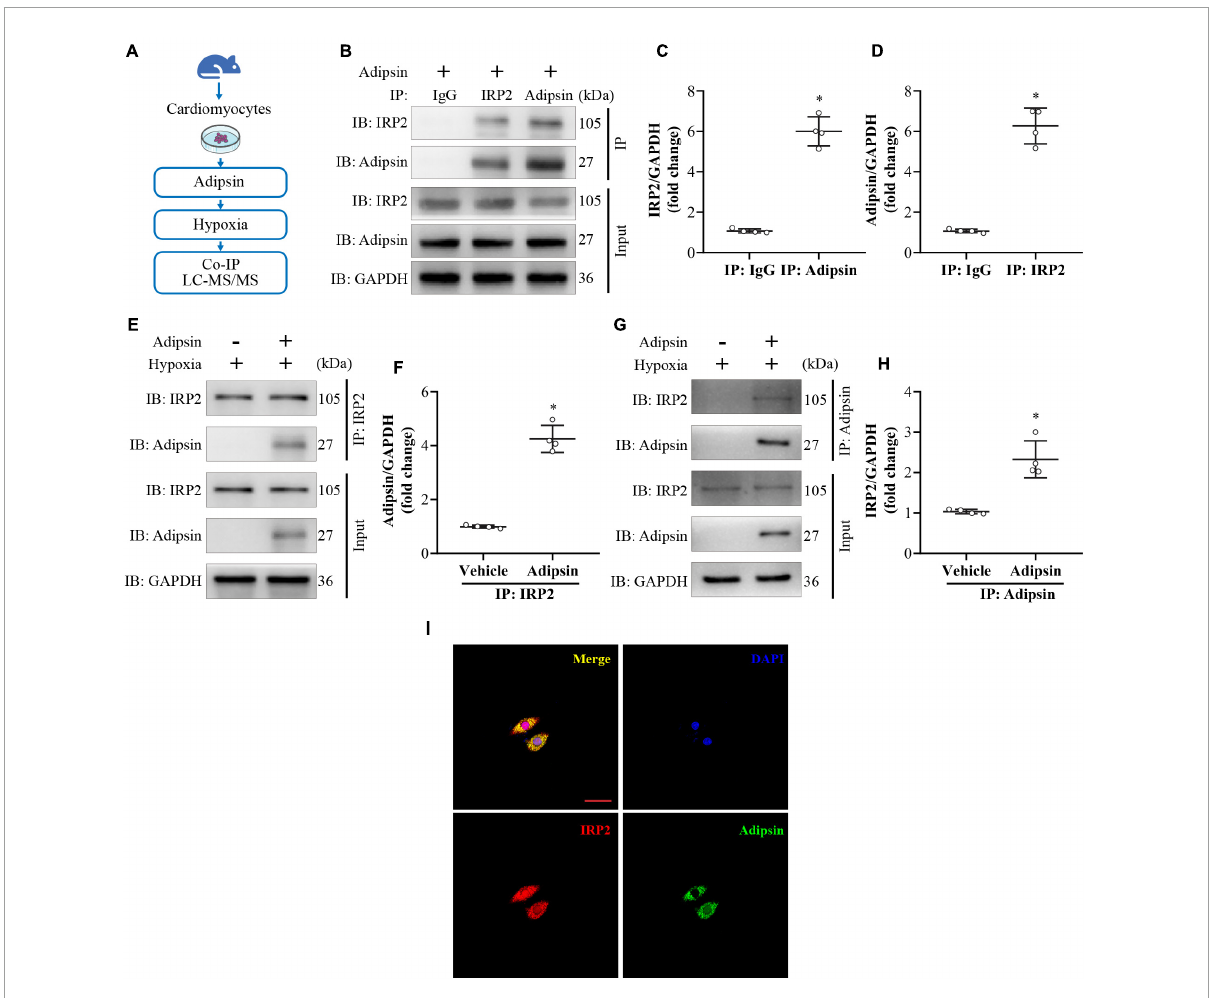
FIGURE6 Adipsin interacts with IRP2 under hypoxia in vitro . (A) Flowchart of the study design. Neonatal mouse ventricular cardiomyocytes were treated with recombinant Adipsin protein. Following that, cardiomyocytes were exposed to hypoxia for 6–8 h. Next, Co-immunoprecipitation (Co-IP) and LC-MS/MS technologies were used to investigate cellular proteins. (B–D) Interaction between Adipsin and IRP2 was demonstrated using Co-IP. * p < 0.05 vs. IP: IgG. (E–H) Co-IP of Adipsin and IRP2 in cardiomyocyte in hypoxic environment. * p < 0.05 vs. Vehicle. (I) The Co-localization of Adipsin (green) and IRP2 (red) proteins in cardiomyocyte. DAPI, 4’,6-diamidino-2-phenylindole. Data were mean ± SEM, and one-way ANOVA was used for statistical